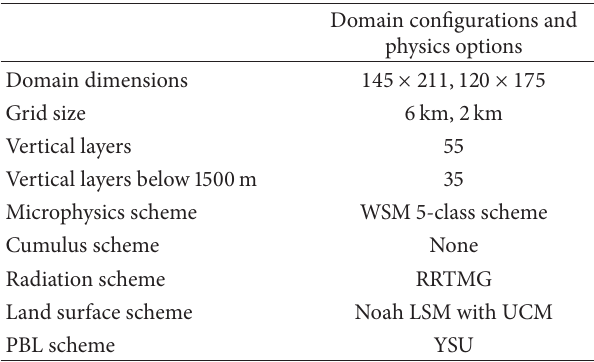
Table 1: Domain configurations and physics options of the WRF